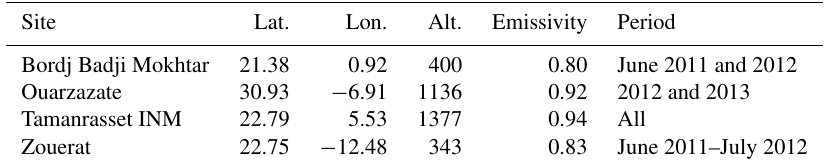
Table 2. AERONET sites of interest with associated latitudes and longitudes (in ◦ N and ◦ E), altitudes (m), June emissivities for the MSG-3 SEVIRI 8.7µm channel, and periods of available data for the summers between June 2011 and July 2013. Site Lat.